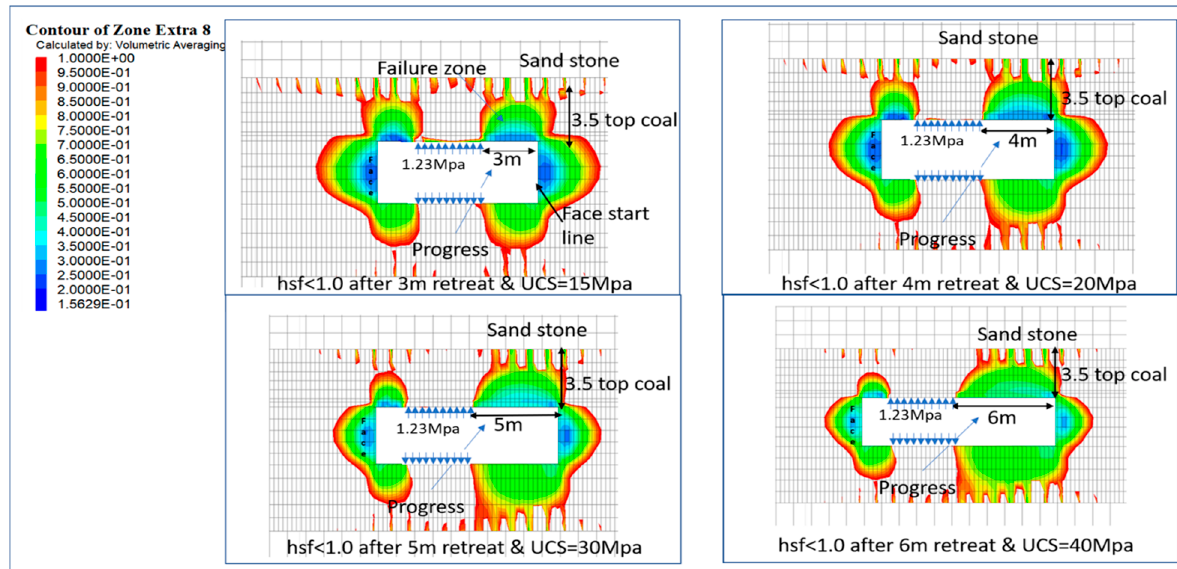
Figure 2. Modeling for different UCS values.